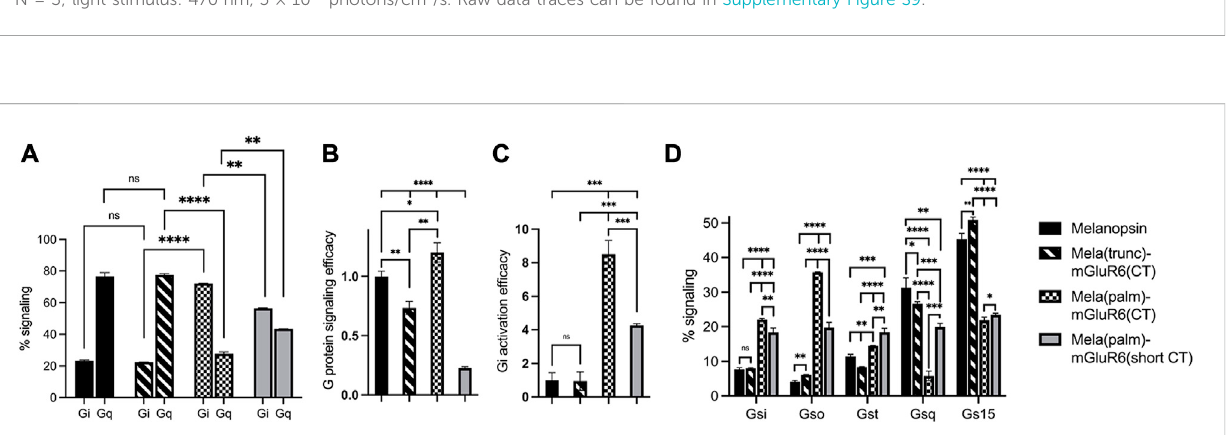
FIGURE 3 Shift from Gq to Gi activation of Mela-mGluR6 chimeras with combined IL3 and C-terminus replacements determined by the GsX second messengerassay.HEK293cellstransfectedwiththerespectiveOptoGPCRplasmids,GloSensorreporterandtheC-terminalmutatedGsq,Gs15,Gsi,Gso, or Gst G-proteins were subjected to a Gs cAMP assay. The maximum cAMP levels were divided by the sum of all values and normalized to 1 for each GsX protein. (A) The total Gq and Gi signaling was calculated by adding the max. cAMP value of Gsq and Gs15, and Gsi, Gso, and Gst, respectively, and dividingbythesumofallGsXresponses todeterminethepercentage ofeachG-protein intotalsignalling. (B) The Giactivation ef fi cacy wascalculatedto quantifytheshiftfromGqtoGisignaling.Thiswascalculatedbydividingthesummedmax.Givaluesbythesummedmax.Gqvalueforeachopsinvariant. (C) The total G-protein signalling ef fi cacy was calculated to determine the signaling functionality by calculating (Gi(total)+Gq(total))/2. WT melanopsin wasnormalizedto1,allothervariantswerenormalizedtoWTmelanopsin.ReplacingtheproximalC-terminusinmelanopsinshiftedG-proteinspeci fi city fromGqtoGi.However,disruptingtheTM7-H8domainofmelanopsinintheMela(NPxxY)variantsigni fi cantlyimpactedtheG-proteinsignallingef fi cacy. N = 3; light stimulus: 470 nm, 5 × 10 16 photons/cm 2 /s. Raw data traces can be found in Supplementary Figure S9.